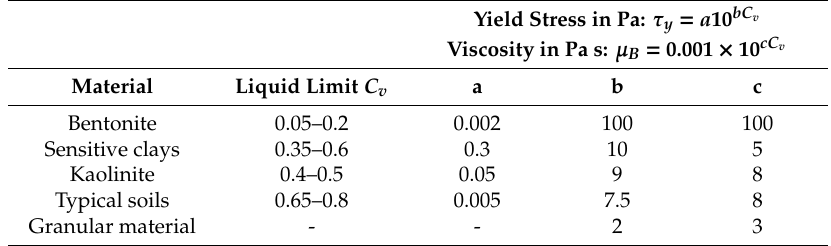
Table 2. Coe ffi cients of the yield stress (yield shear stress) and viscosity relationships